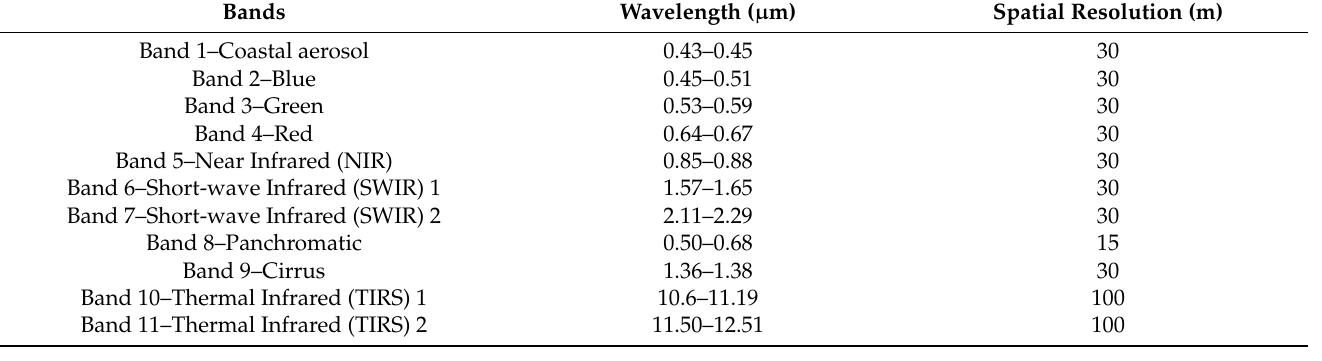
Table 1. Characteristics of Landsat 8 imagery.